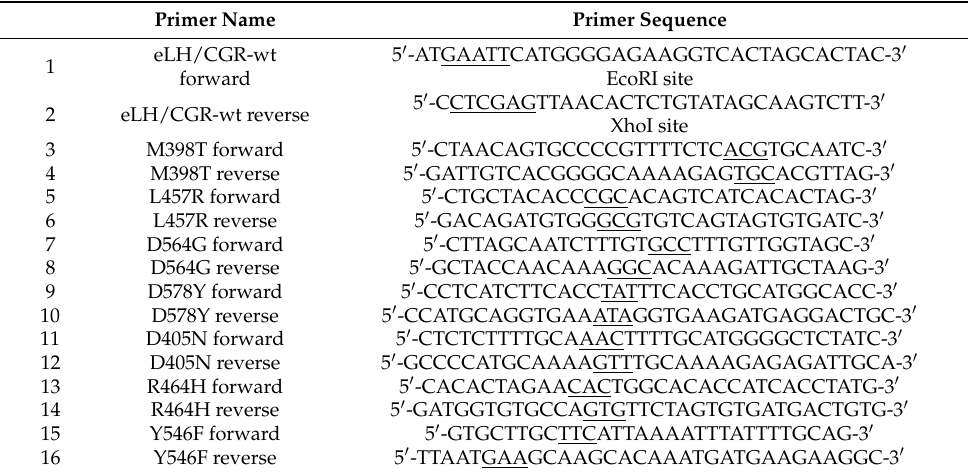
Table 5. List of primers used to construct eLH/CGR